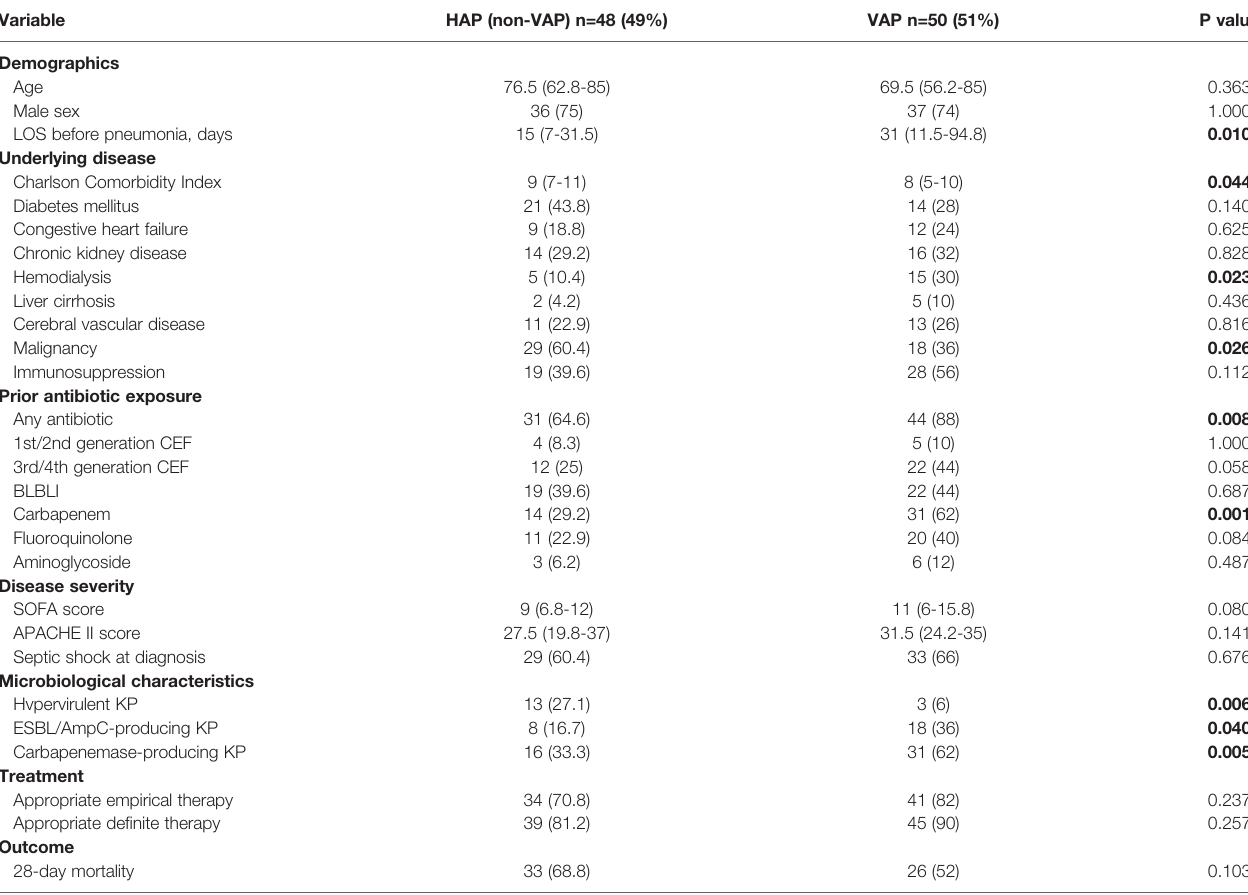
TABLE 3 | Characteristics of patients with nosocomial bacteremic pneumonia.